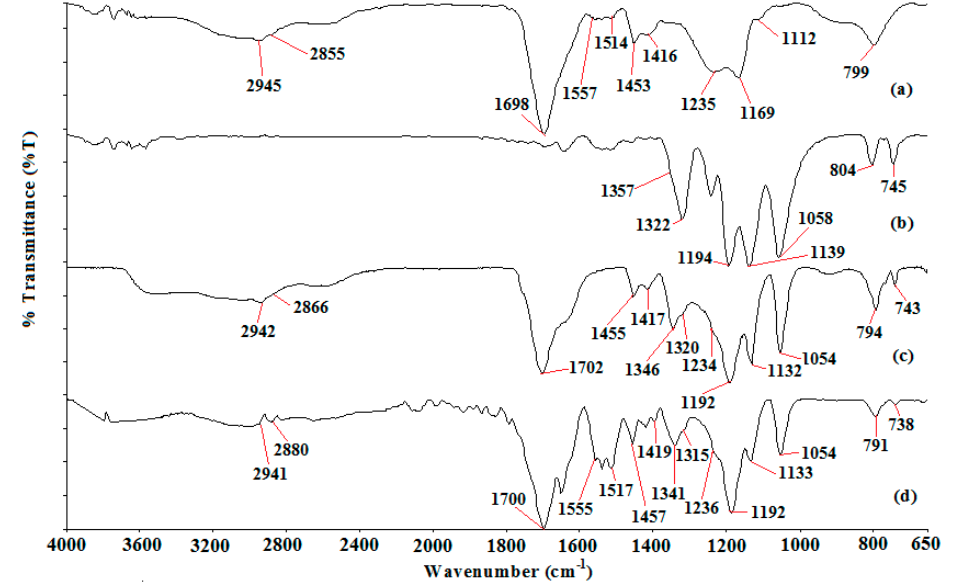
Figure 1. FTIR spectrum of ( a ) PAA; ( b ) LiTFSI; ( c ) Ti 0 and ( d ) Ti 3.